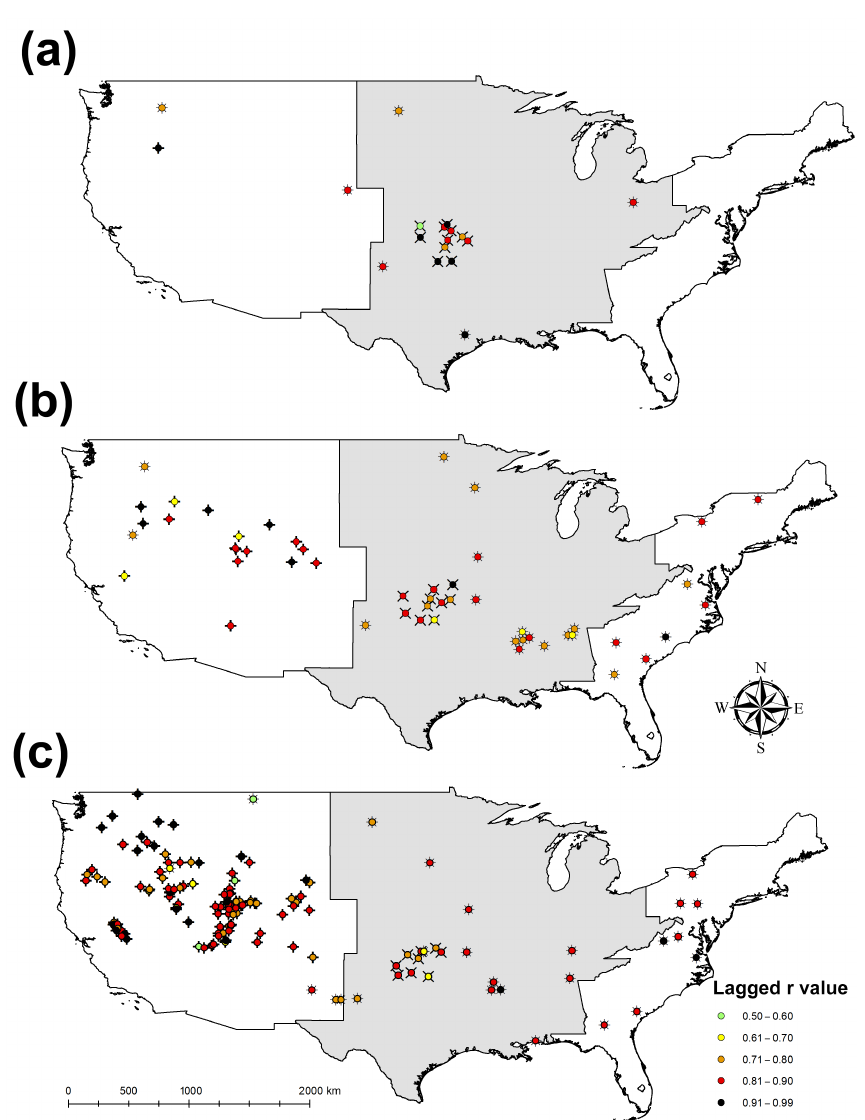
Figure 1. Locality map of examined in situ stations (ARM: X; SCAN: ∗ ; SNOTEL: + ) with (a) era 1, (b) era 2, and (c) era 3. The gray area represents the central CONUS, whereas white indicates the eastern and western regions of